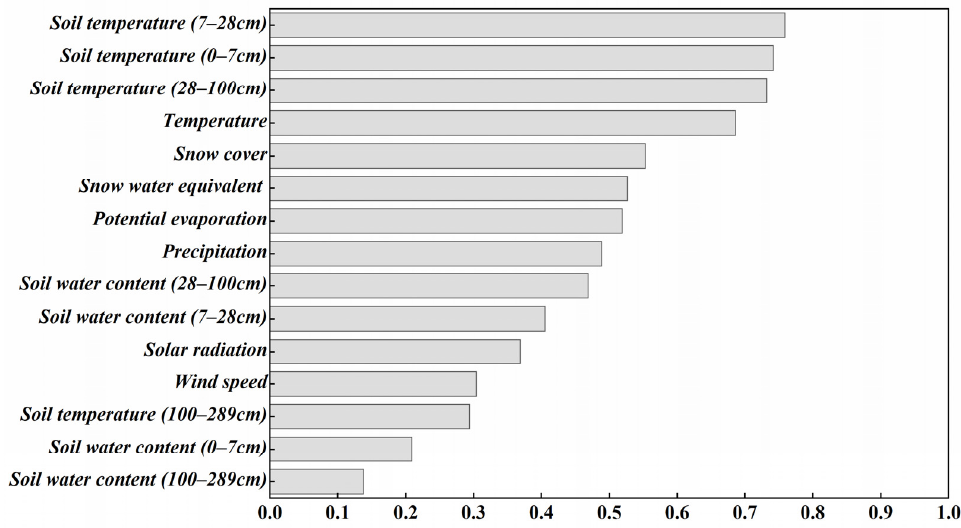
Figure 7. Pearson correlation coefficients of the input features.